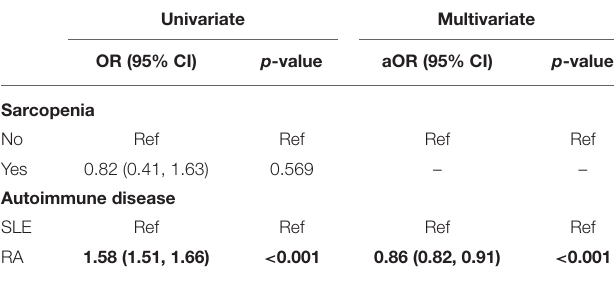
TABLE 5 | Associations between sarcopenia, type of autoimmune disease and the presence of MI. Univariate